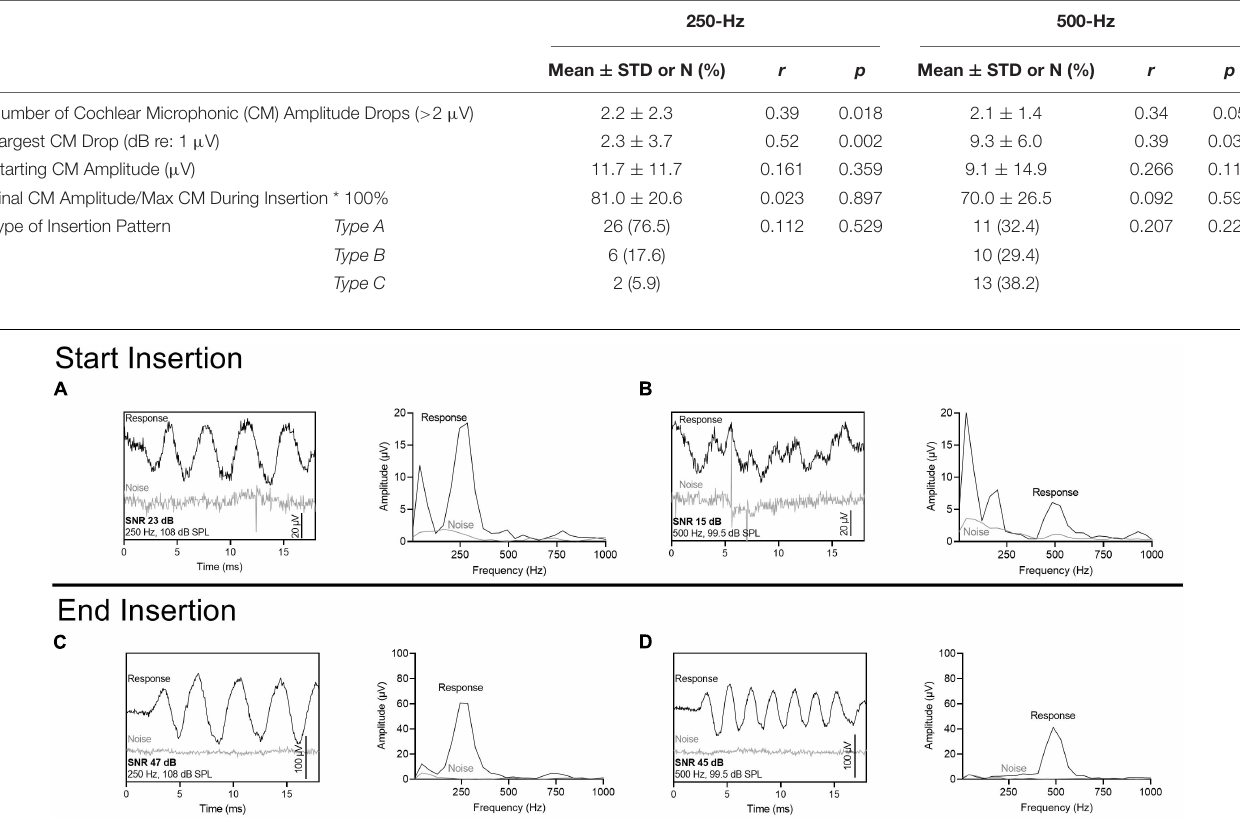
FIGURE 4 | ECochG recording (difference curves) using the most apical electrode at the start of the insertion and at the end of insertion. Stimulus parameters were sequential, alternating phase presentations of 250- and 500-Hz tone bursts, with a single repetition per phase. Fast Fourier transformations are also shown.